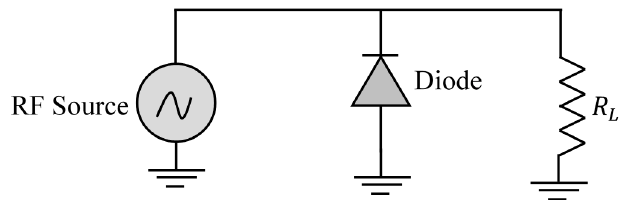
Figure 12. Schematic for the diode detection threshold.